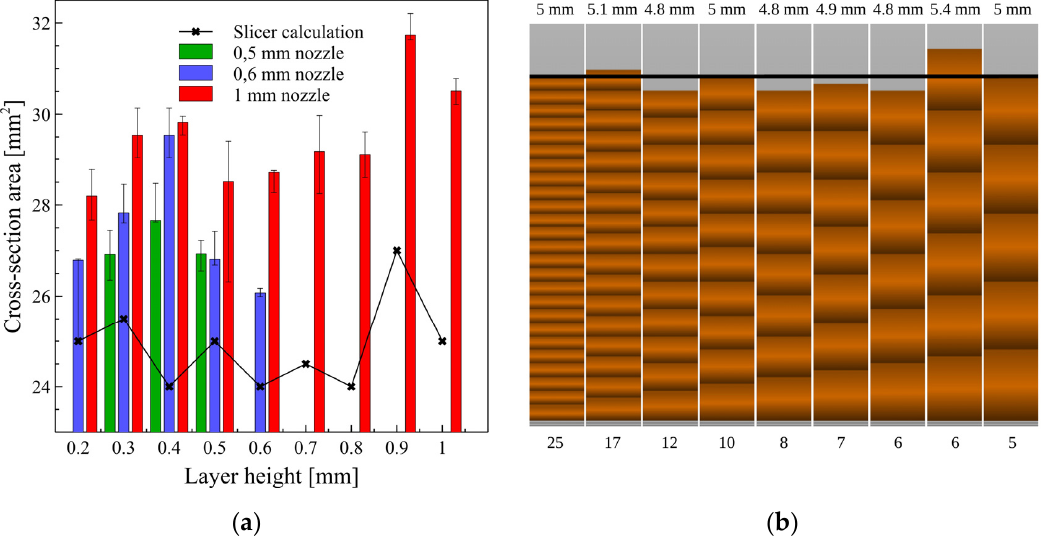
Figure 5. ( a ) Geometry measurements (cross-section areas) of the samples printed with nozzle diameters from 0.5 to 1 mm, and a wide layer thickness range. ( b ) Comparison of the samples generated by slicer with 5 mm height set as the initial value (black line)—upper values correspond to the calculated height as a multiplication of layer thickness, and bottom values correspond to the number of generated layers, respectively.